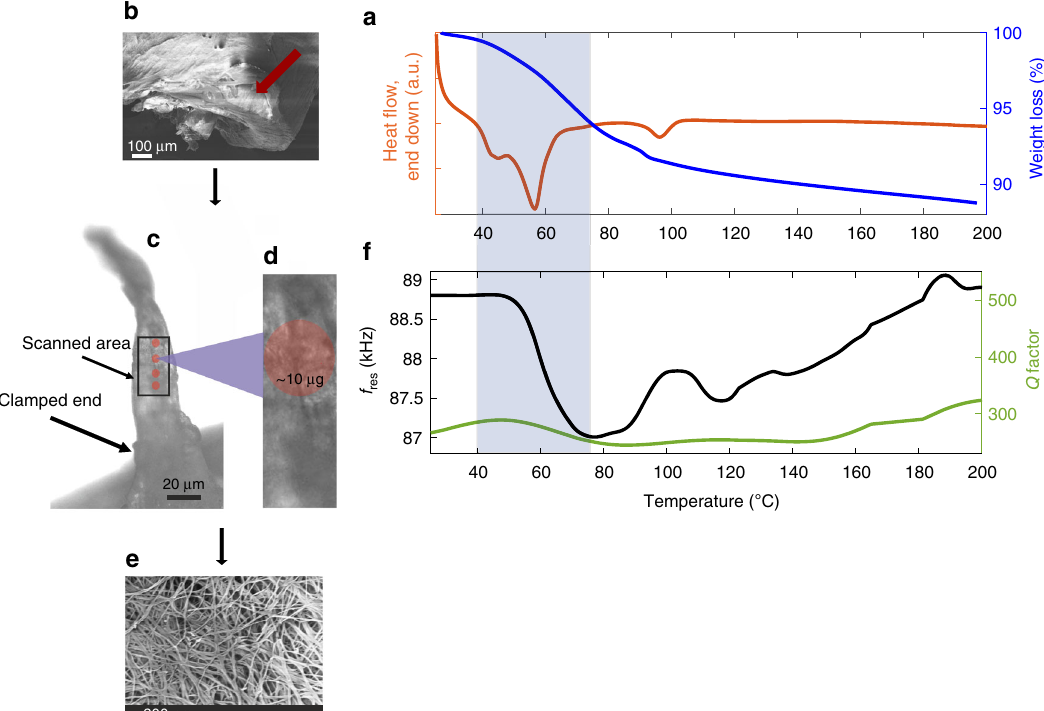
Fig. 6 Thermomechanical analysis of collagen fi bres. a DSC and TGA thermograms (25 – 200 °C, 20 °C/min) of collagen fi bres ( ∼ 14 mg). b Scanning electron microscopy (SEM) image shows a bundle of collagen including several layers, where a small piece of the external layer (shown by the red arrow) is cut and used for the PMTA measurement. c A represention of the area that was scanned during the PMTA experiment and the thin roll of rat-tail collagen fi brils that was applied as a cantilever. d A zoom in of c for visualisation of the entanglement of the collagen fi brils. e A zoom in of the collagen fi brils